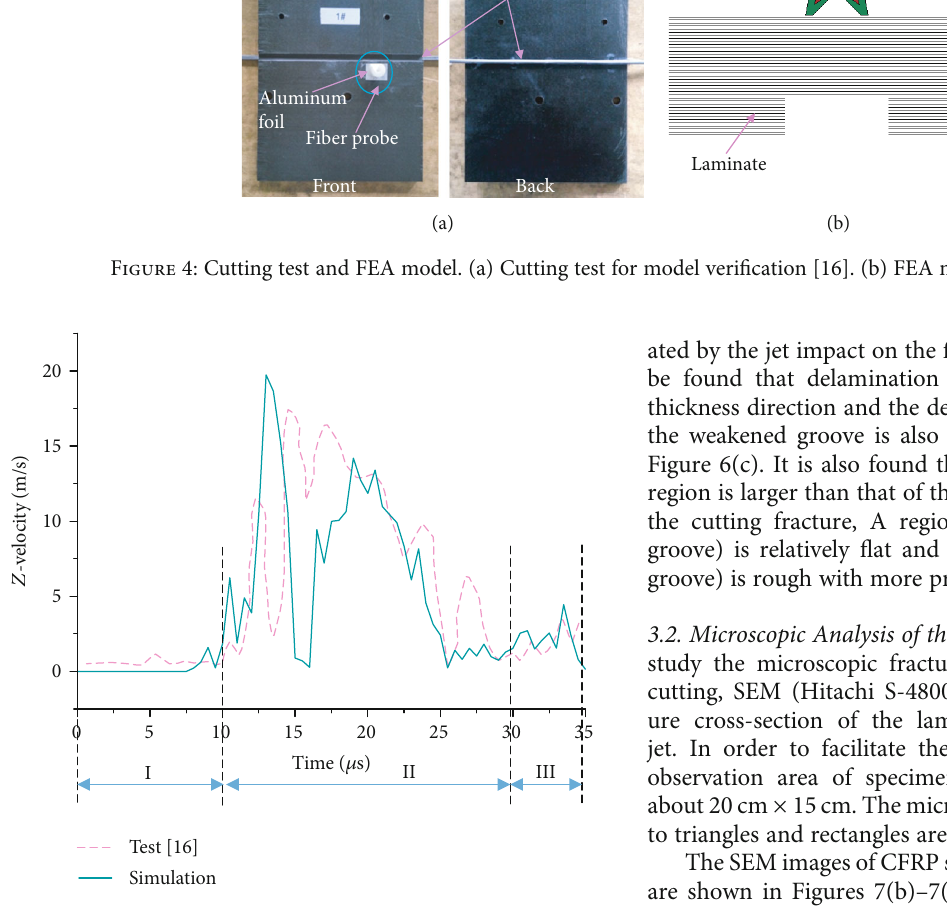
Figure 5: Velocity curves of the feature point of